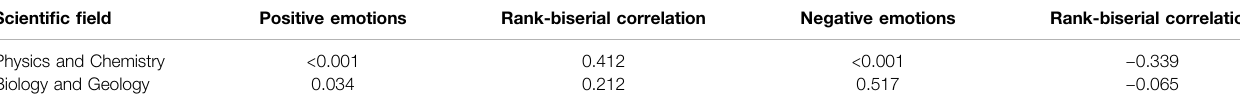
TABLE 1 | Mann-Whitney U -test p -values for gender differences in negative and positive emotions toward